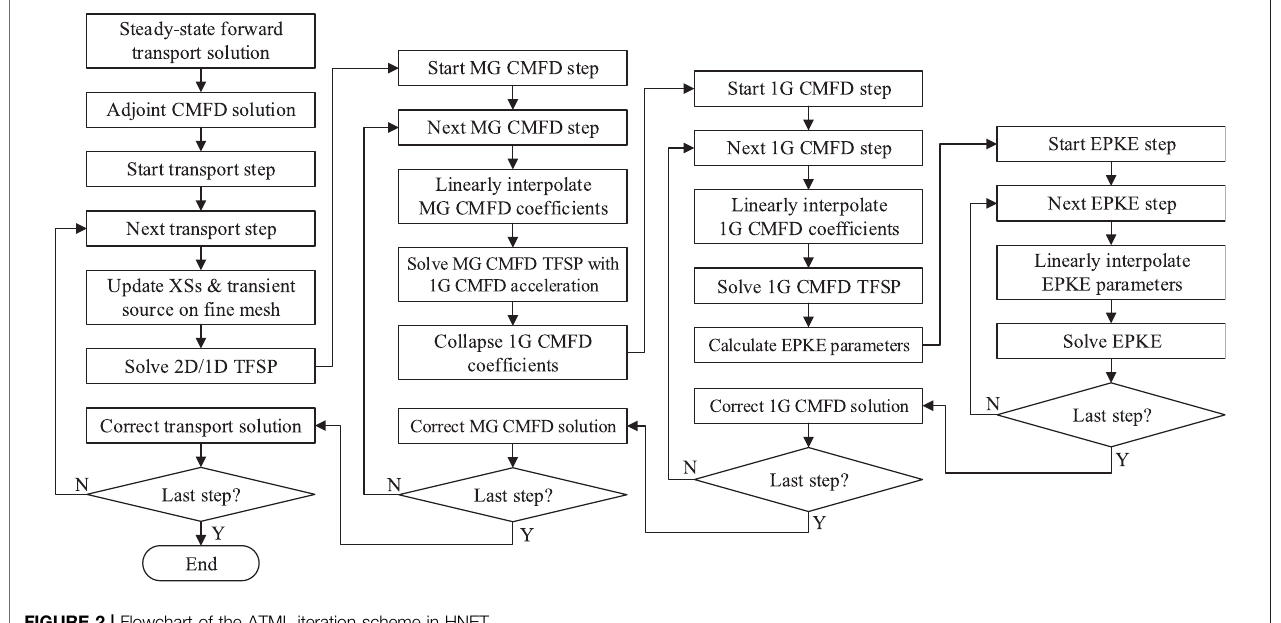
FIGURE 2 | Flowchart of the ATML iteration scheme in HNET.